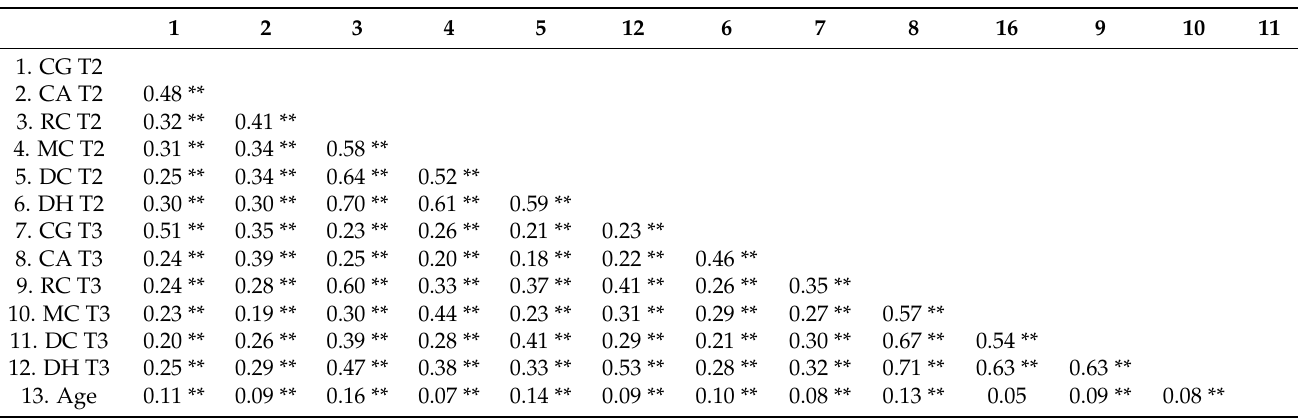
Table A1. Correlations among All Study